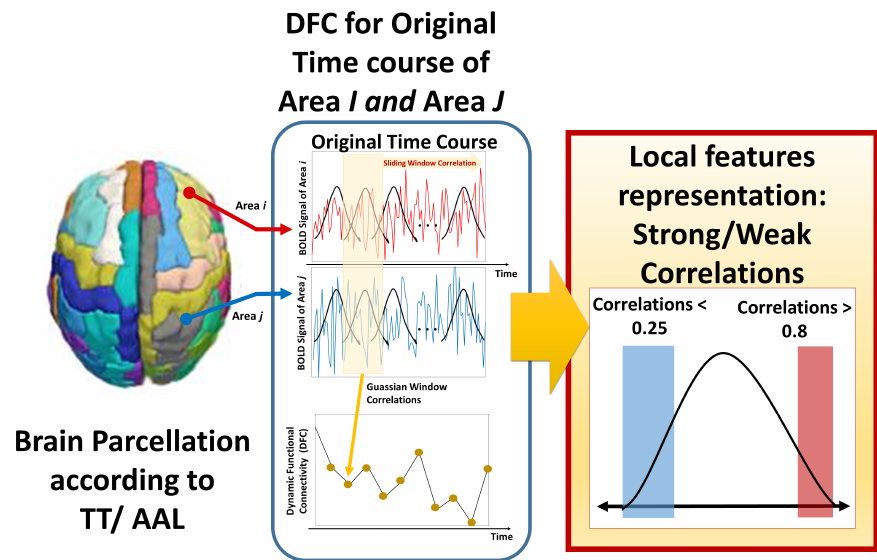
Figure 3. Visual diagram of the calculations of the dynamic functional connectivity dFC representa- tion, extracted from two different brain